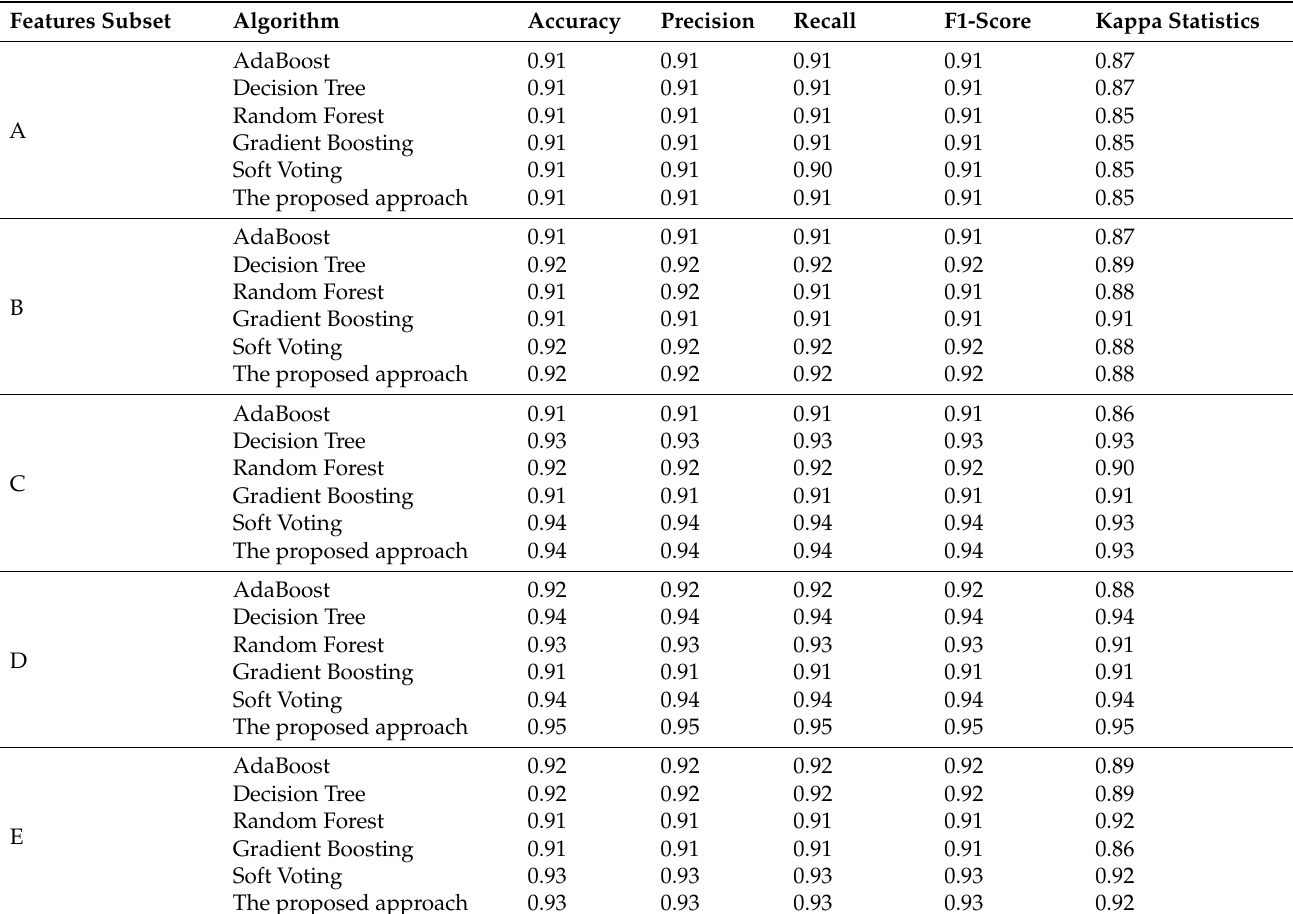
Table 4. Comparison of the performance of the proposed approach and other machine learning algorithms. Features Subset